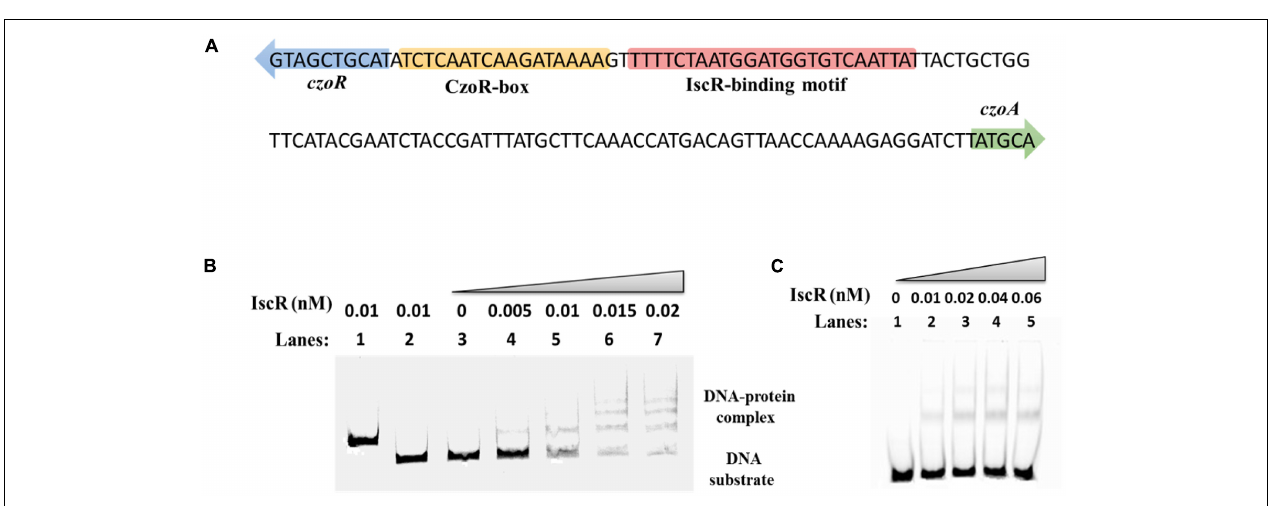
FIGURE 5 | EMSA analysis for the IscR interaction with the czoR – czoA intergenic region. (A) IscR-binding motifs extracted from RegPrecise were used to identify potential IscR-regulated genes. A putative IscR-binding motif was located in the region between czoR and czoA . (B) EMSA analysis results for the IscR interaction with the czoR – czoA promoter. Bands 1–3 represent negative controls: 1, DNA probe containing no IscR-binding motif (non-specific DNA probe) in the presence of IscR; 2, DNA probe containing the putative IscR-binding motif (specific DNA probe) in the presence of heat-inactivated IscR; 3, specific DNA probe only; Bands 4–7 represent different concentrations of IscR added with a 1.8 pmol FAM-label of the DNA probe. (C) EMSA analysis results for the DNA-binding activity of IscR with a conserved 30 bp